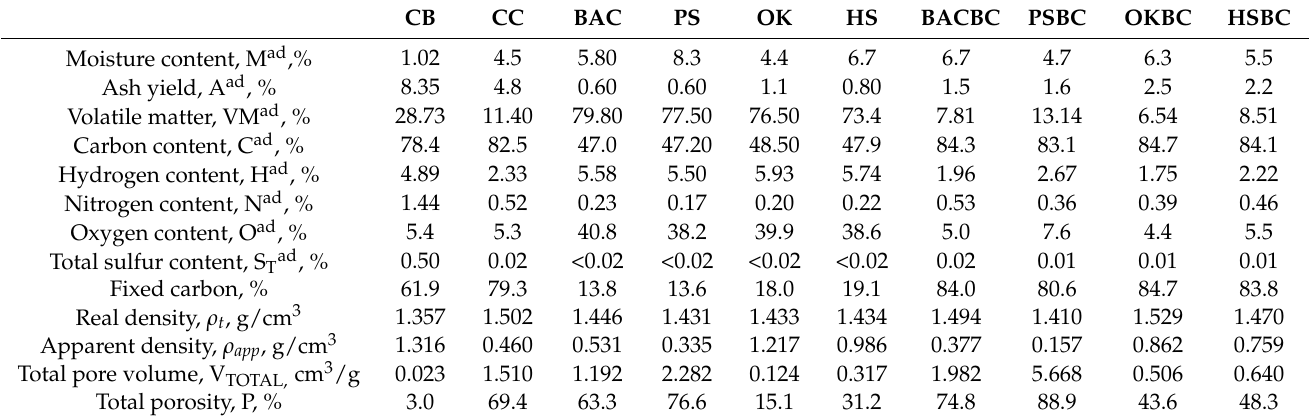
Table 1. Properties of used coal blend, raw and carbonized biomass ( ad –air dried